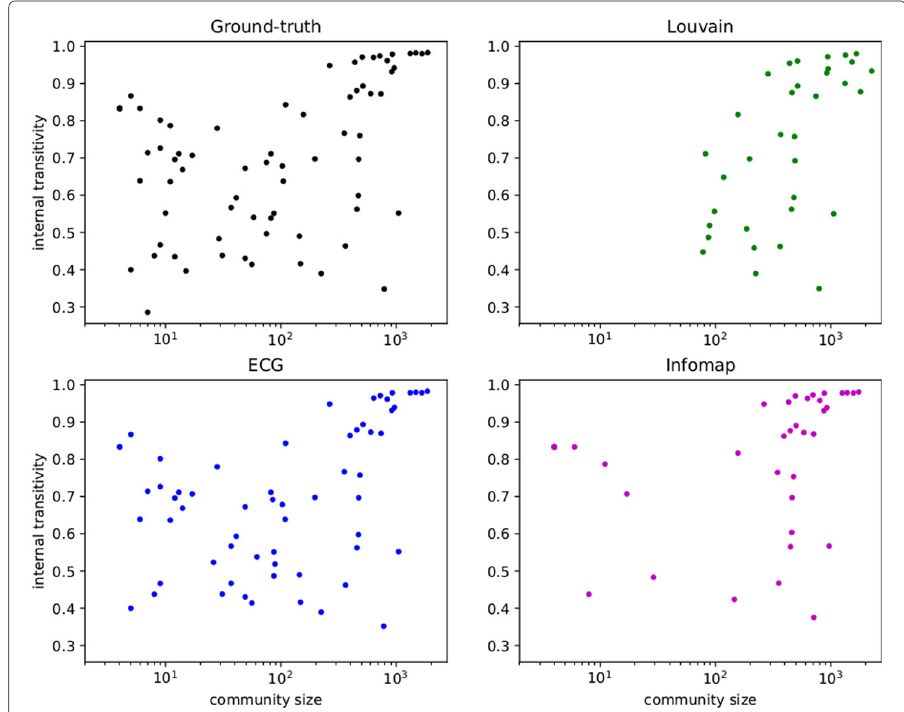
Fig. 9 For an LFR graph with parameters μ = .39, γ 1 = 2 and γ 2 = 1, we plot the internal transitivity of the ground-truth communities as a function of their sizes and compare with the clusters found with ECG, Louvain (ML) and Infomap (IM). The resolution issue with ML (larger size communities) is not present with ECG, which shows structure very close to the ground-truth